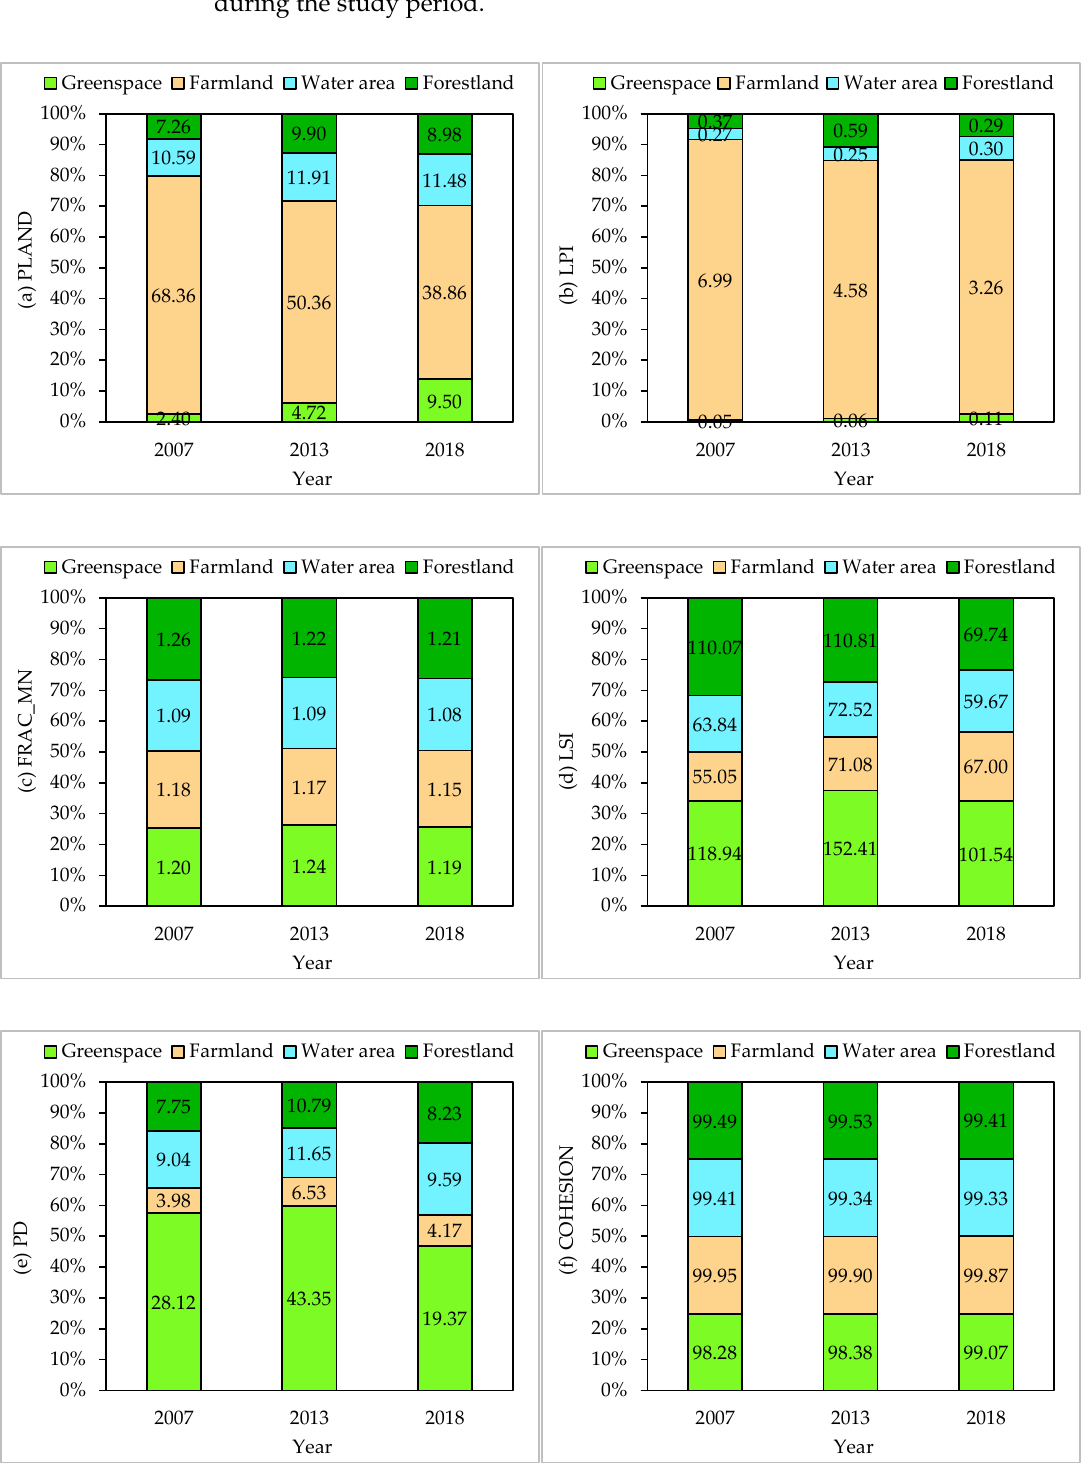
Figure 3. Changes in each type of GI indicator